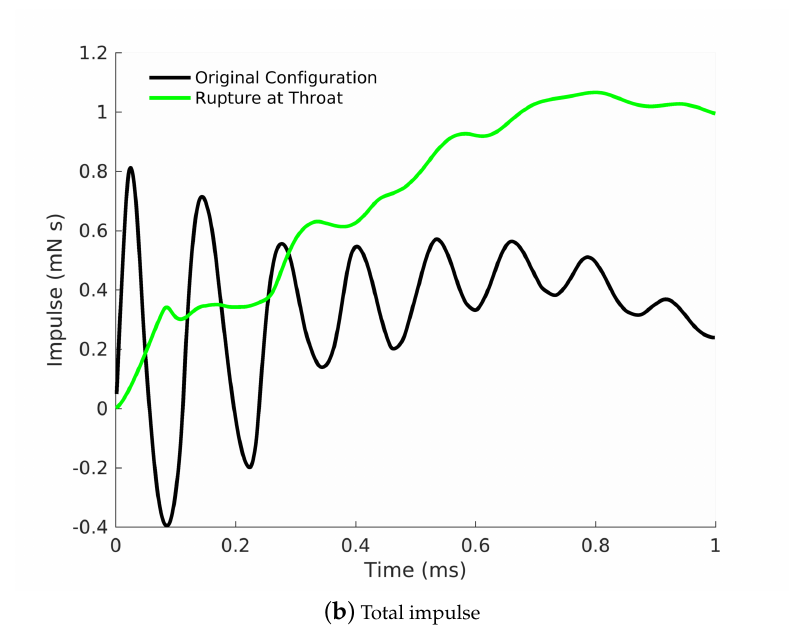
Figure 14. Simulated nozzle performance as a function of